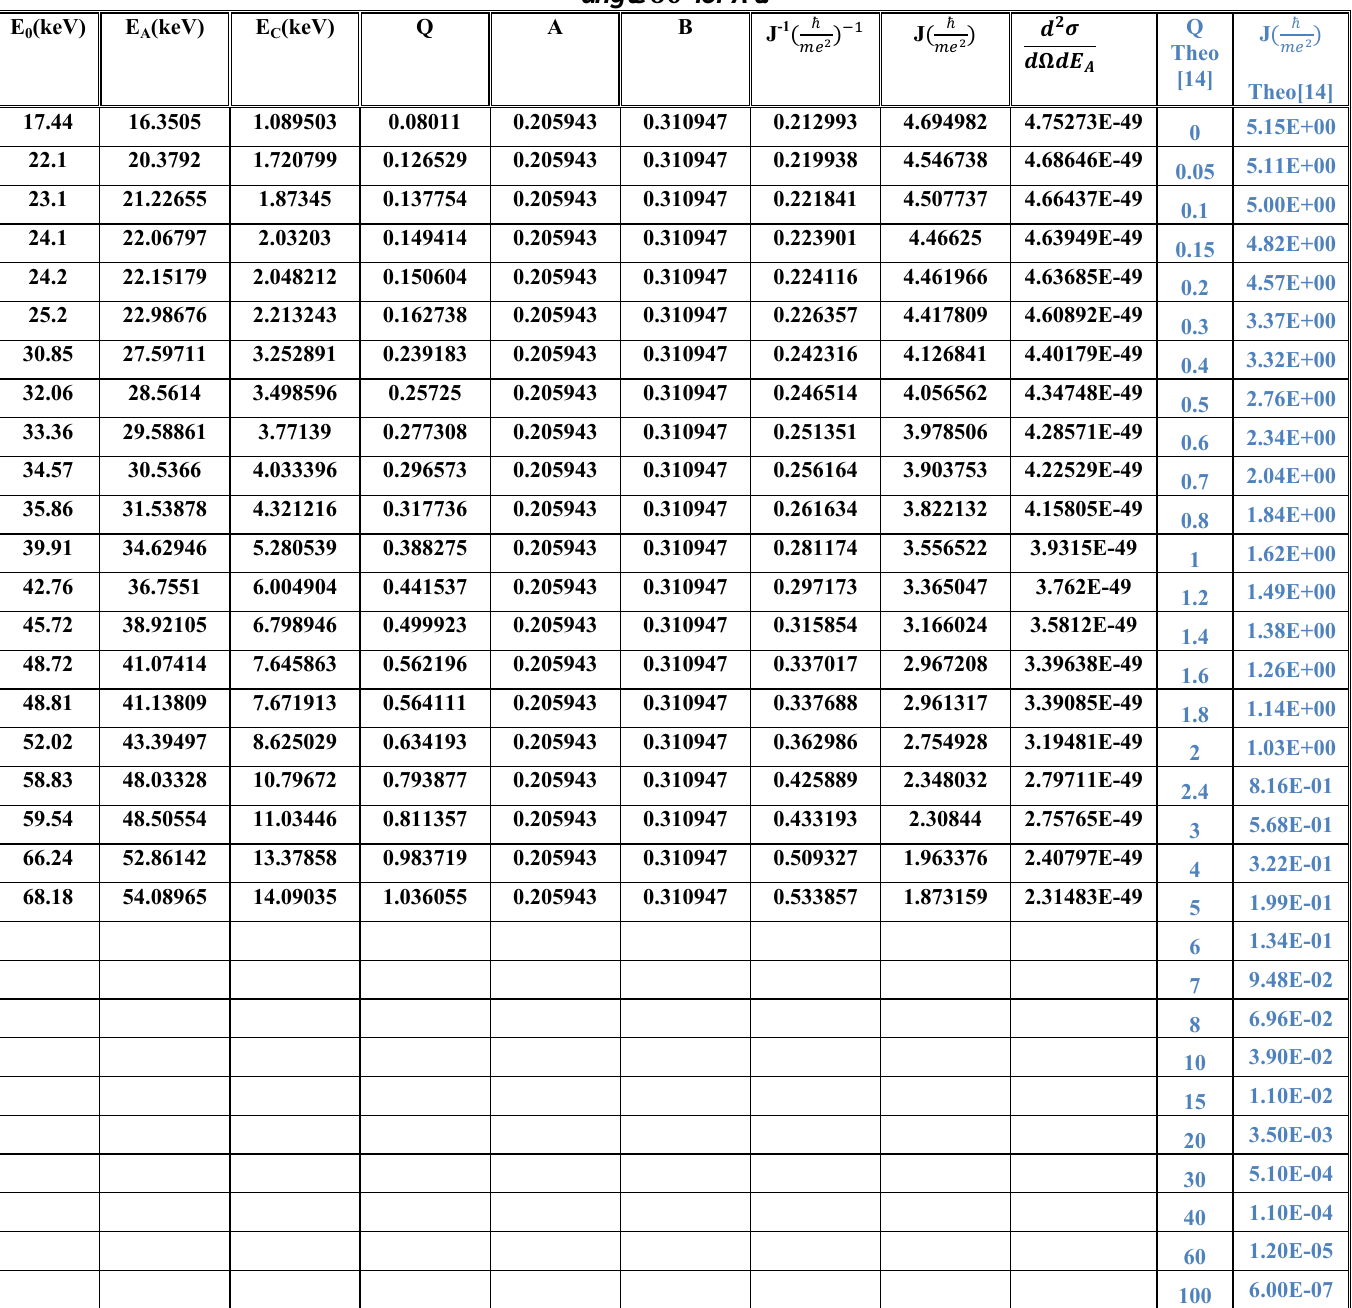
Table 3: The double-differential scattering cross section of Doppler broadening at angle (cid:2783)(cid:2777) ° for